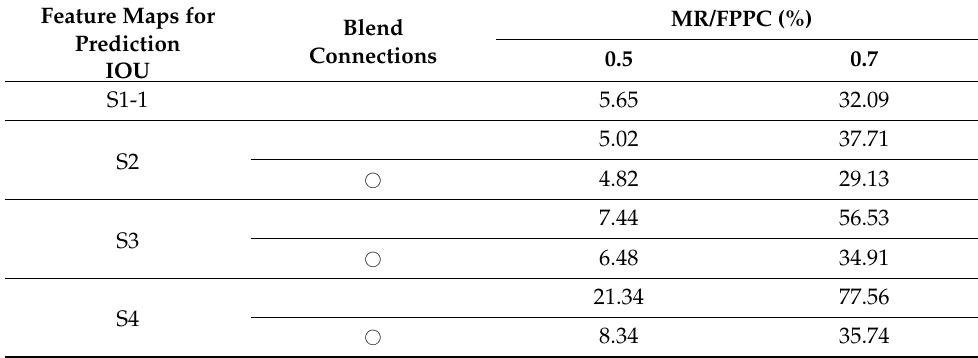
Table 3. Performance comparison using the down-sampling branch with and without blend connections. Feature Maps